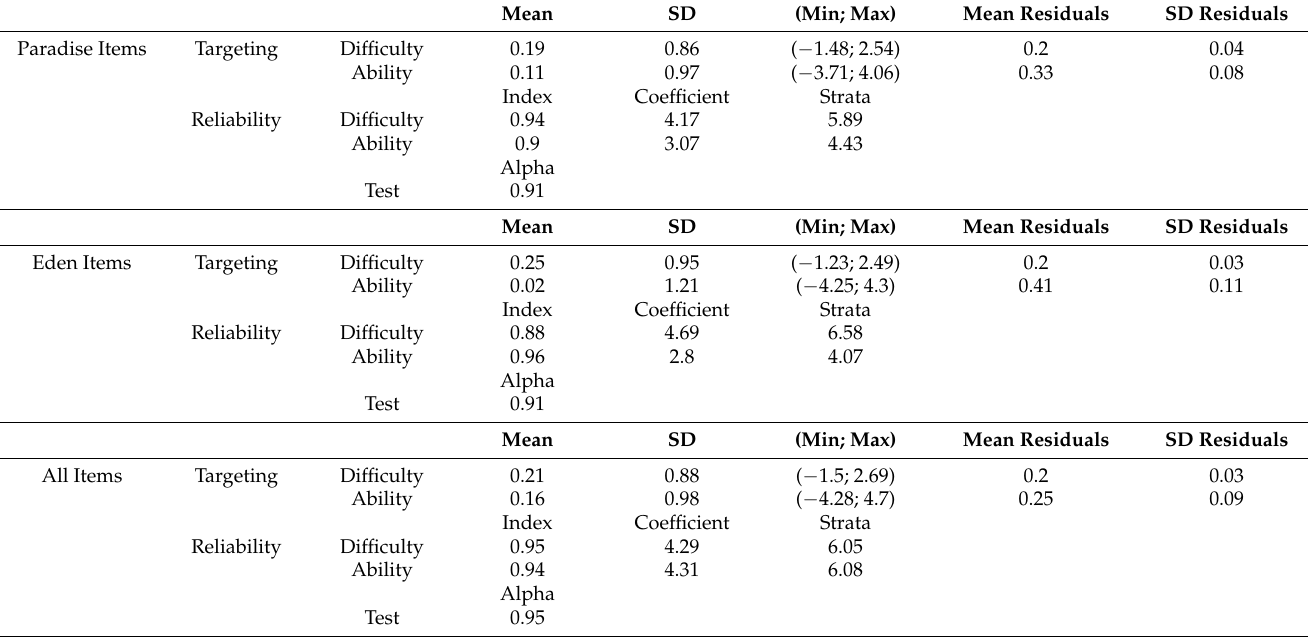
Table 3. Model fit including person-item targeting and reliability indices for the 24 Paradise items, the 18 additional Eden items, and the two combined. Mean SD (Min; Max) Mean Residuals SD